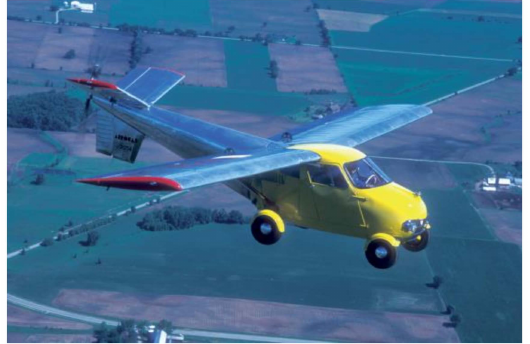
Figure 6. A 1949 Taylor Aerocar—N4994P